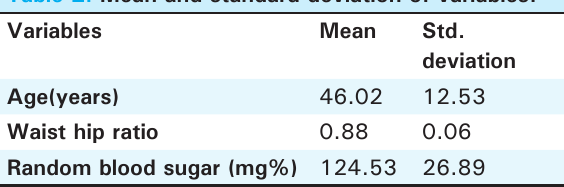
Table 2. Mean and standard deviation of variables.